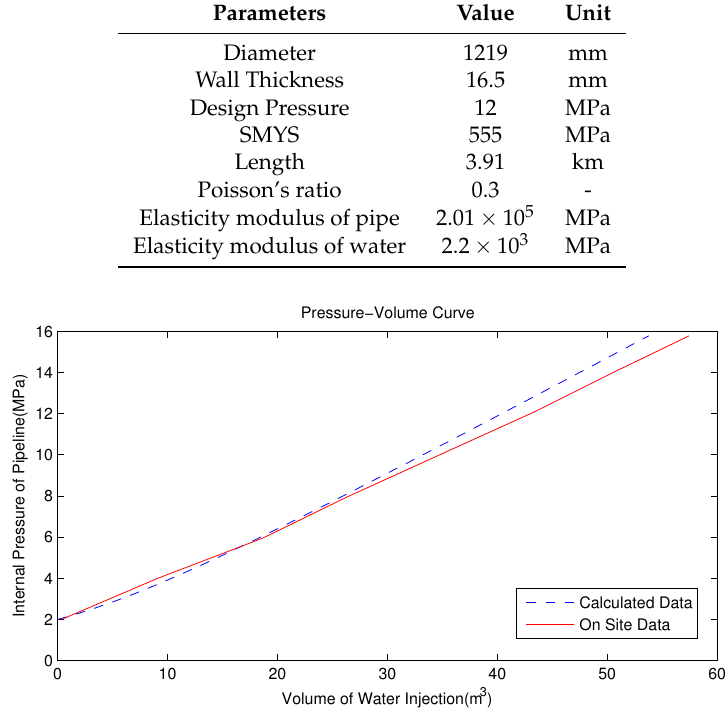
Figure 2. Pressure–volume data recorded on-site vs. the calculated